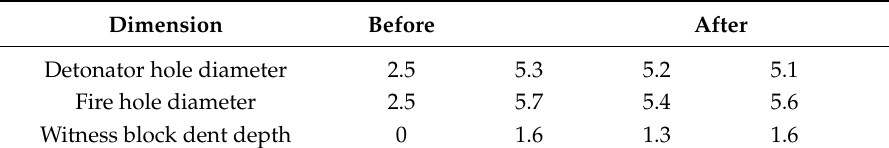
Figure 32. Explosion test device.